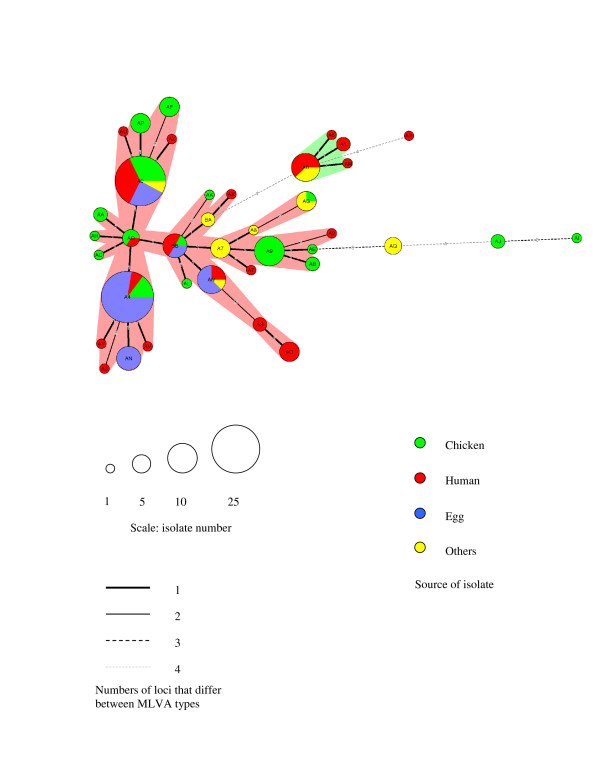
Minimum-spanning tree of MLVA. Each MLVA type is indicated by one node or branch tip, displayed as circles that are connected by branches of minimum-spanning tree. A two-letter code within each circle uniquely identifies each MLVA type, which is coded in a combination of the first letter ("A" or "B") and the second letter (any of alphabetical "A-Z" or a numerical "1–9 "). Clonal complexes were created based on maximum neighbor distance of changes at two loci and minimum size of two types. The length of the branches represents genetic distances (changes in loci) between two neighboring types. The sizes of the different color-circles depend on their population size. Wedges in circles indicate the proportion of isolates from respective sources with a particular MLVA type. In case of equivalent solutions in terms of calculated distance, the highest number of single locus variants (SLVs; in case two types have an equal distance to a linkage position in the tree, the type that has the highest number of SLVs is linked first) associated was used as the priority rule for linking types in the tree.